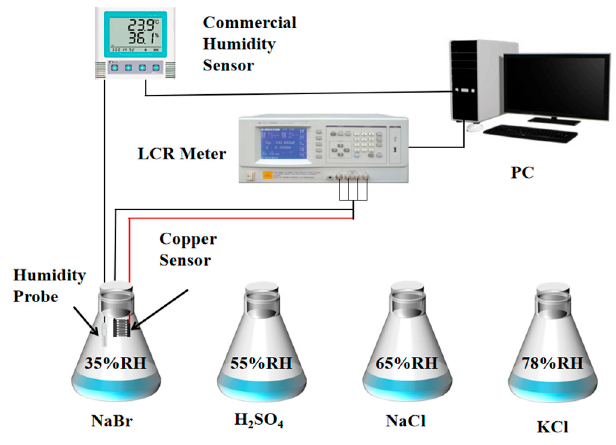
Figure 3. Schematic diagram of humidity sensing experimental device.